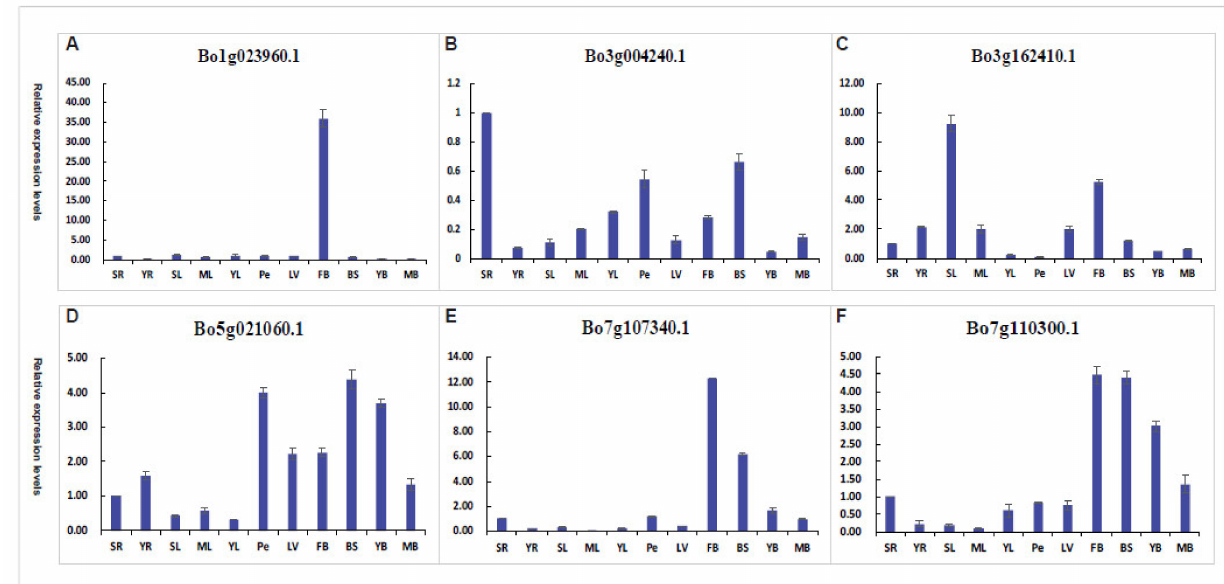
Figure 11. Tissue-specific qRT-PCR analysis of putative six Bo2OGD genes. ( A – F ) respectively represent the tissue-specific qRT-PCR analysis of a single Bo2OGD gene. Sample identifiers: senescent leaves (SL), mature leaves (ML), young leaves (YL), leaf veins (LV), petioles (Pe), young bolting stem flesh (YB), middle-aged bolting stem flesh (MB), bolting stem skin (BS), flower buds (FB), senescence roots (SR), and young roots